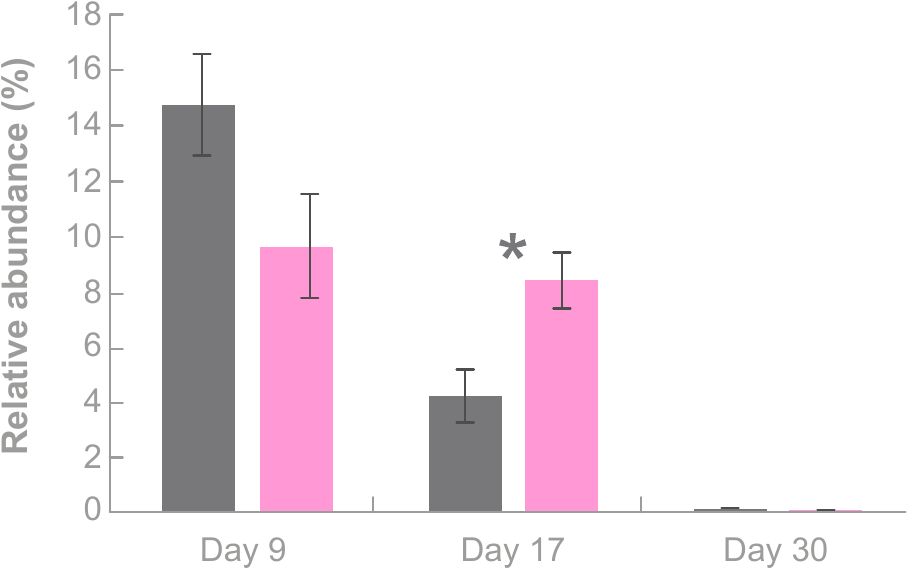
Figure 3. Relative abundance (%) of Bacteroides species in the gut of 9-, 17-, and 30-day-old piglets in the control (grey bars) and supplemented with Tonisity Px (pink bars) groups. Bars represent LSmeans and error bars denote ± SEM. * Indicates statistical significance between treatments at p < 0.05.